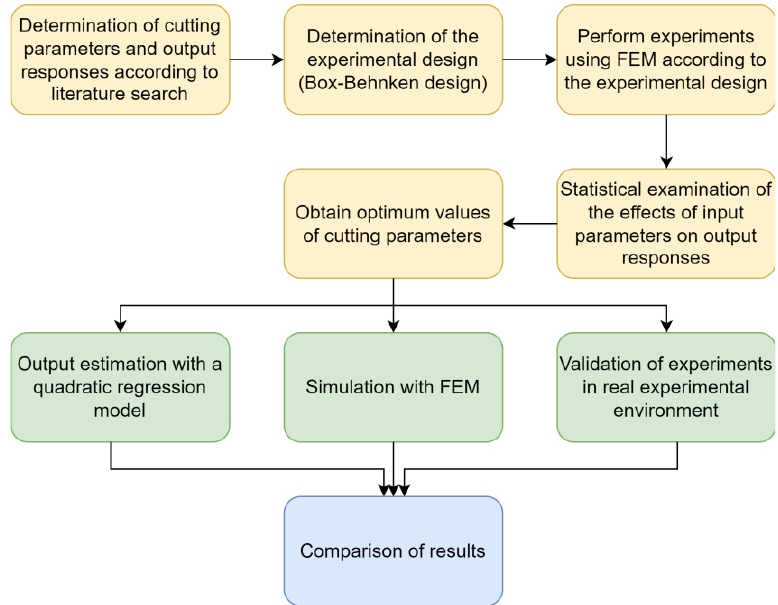
Figure 1. The proposed methodology.